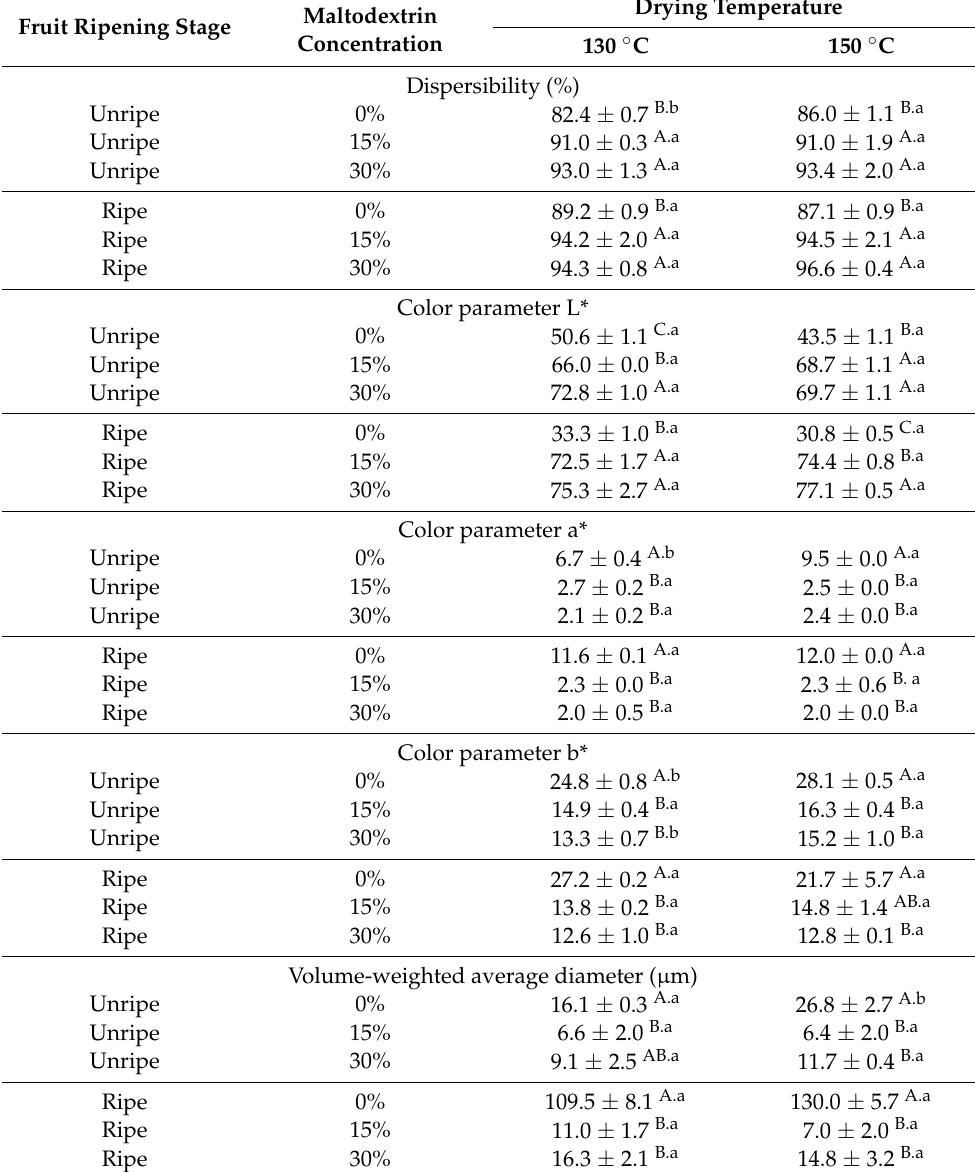
Table 2. Cont. Fruit Ripening